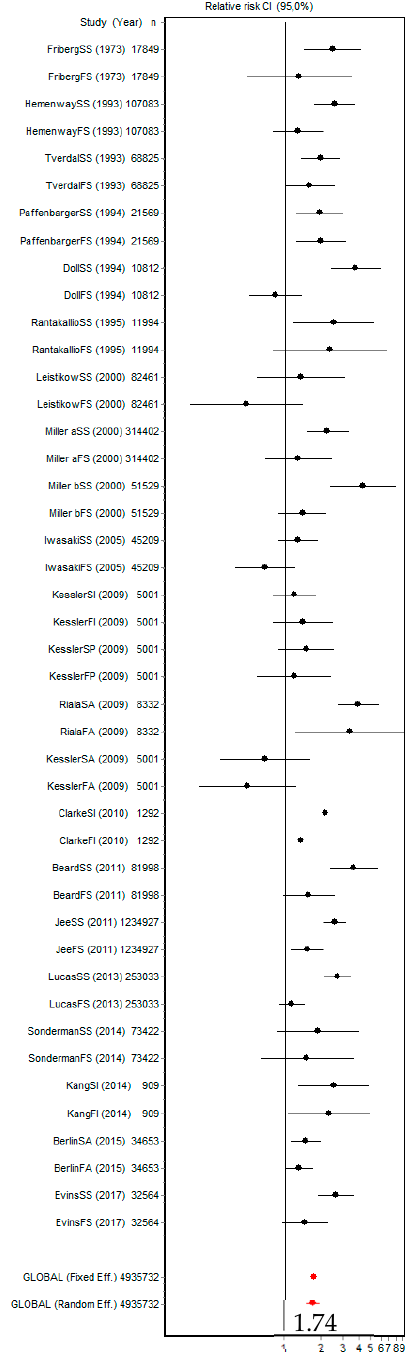
Figure 4. Forest plot for all the reported suicidal behaviours (ideation, plans, attempts, and death by suicide) in former and current smokers.